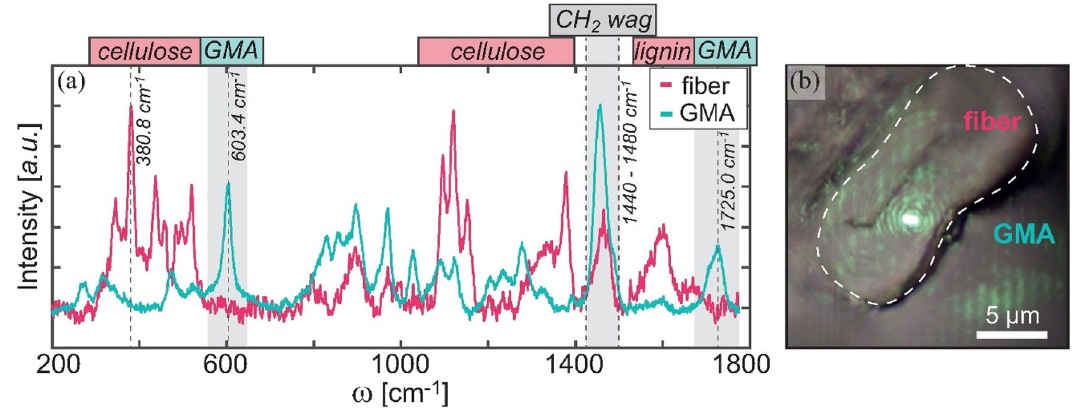
Figure 3. ( a ) Raman spectra of the fiber and the surrounding GMA. Two characteristic modes of GMA (at 603.4 cm −1 and 1725 cm −1 ) that were not observed in the fibers are highlighted. CH 2 wagging mode (1440– 1480 cm −1 range) and a characteristic cellulose mode at 380.8 cm −1 are also highlighted. ( b ) 20 × 20 µm 2 optical microscopy image of the fiber embedded in GMA. The dashed white line marks the fiber perimeter. The laser spot on the sample is visible and marks the spot from which the Raman spectrum ( a ) of the fiber was measured. For the reported GMA spectrum, the laser spot was positioned in the bottom-right of ( b ).